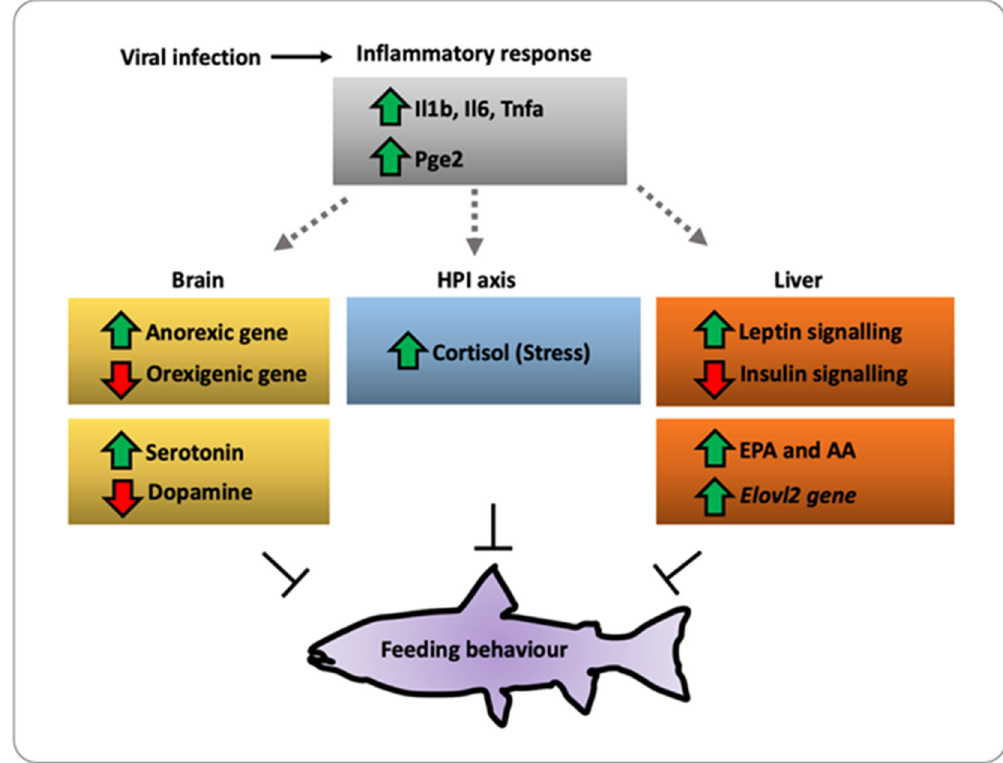
Figure 8. A working model of the immune–sensory interface. Working model based on the results obtained in the present study integrating the HPI axis, immune response, and appetite regulation. We propose that pathogens or organ injury modifies the behavior of critical enzymes such as elov2 and elov5, modifying the lipid metabolism and finally impacting the feeding